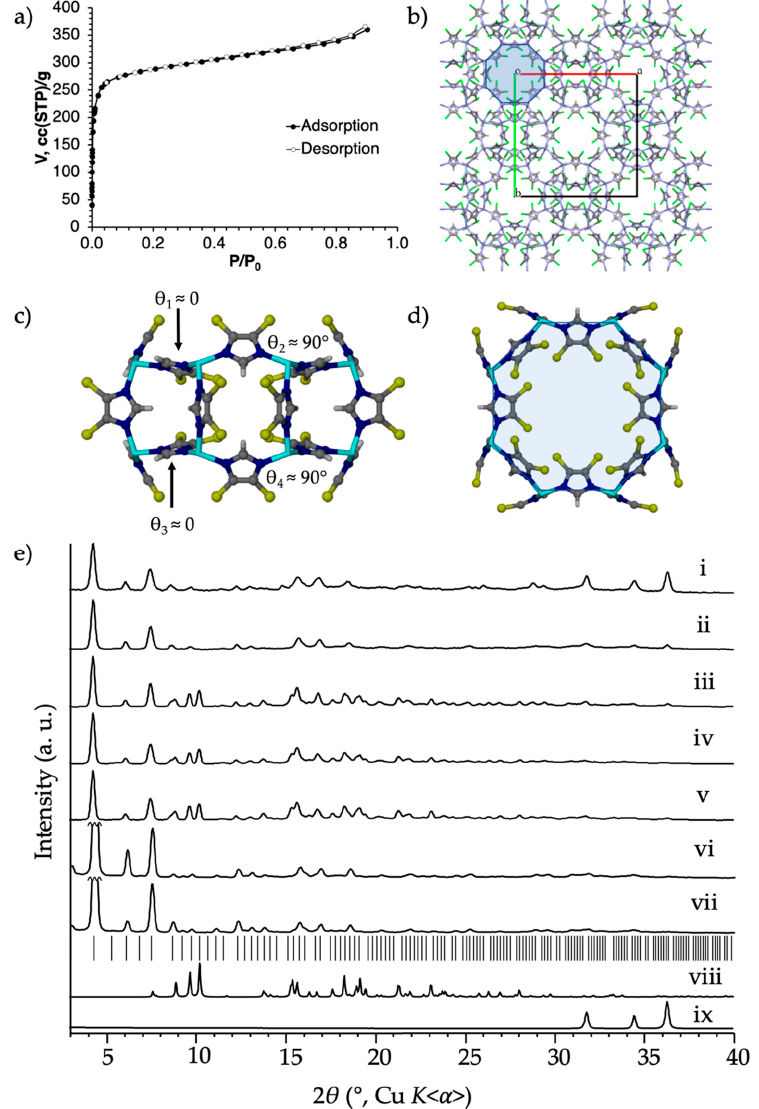
Figure 3. Synthesis and characterization of 0.2 MeMeCH 2 @RHO-Zn 16 ( Cl 2 Im ) 32 (0.2 MeMeCH 2 @ZIF-71). ( a ) The 77 K low pressure N 2 isotherm. ( b ) The crystal structure of RHO-Zn( Cl 2 Im ) 2 (CSD code GITVIP) as viewed down the [001] axis (the d8r motif is shaded blue). ( c , d ) Side and top views of the d8r motif of RHO-Zn( Cl 2 Im ) 2 (shaded blue). ( e ) Powder X-Ray diffraction (PXRD) patterns of the non- templated liquid-assisted grinding (LAG)-aging reaction of ZnO and H Cl 2 Im after (i) 3 days and (ii) 12 days; the MeMeCH 2 templated LAG-aging reaction of ZnO and H Cl 2 Im after (iii) 1 day and (iv) 3 days; the templated large scale ( ≈ 1.7 g) LAG-aging reaction of ZnO and H Cl 2 Im (v) after 3 days, and (vi) the washed 0.2 MeMeCH 2 @RHO-Zn 16 ( Cl 2 Im ) 32 final product after 4 days, and (vii) the same material after activation and 77 K low pressure N 2 sorption analysis. (viii) Simulated PXRD pattern of MeMeCH 2 ⋅ 2DEF (ix) PXRD pattern of nanoparticulate ZnO. Tick marks denote predicted peak positions of the RHO-Zn( Cl 2 Im ) 2 (ZIF-71, GITVIP).